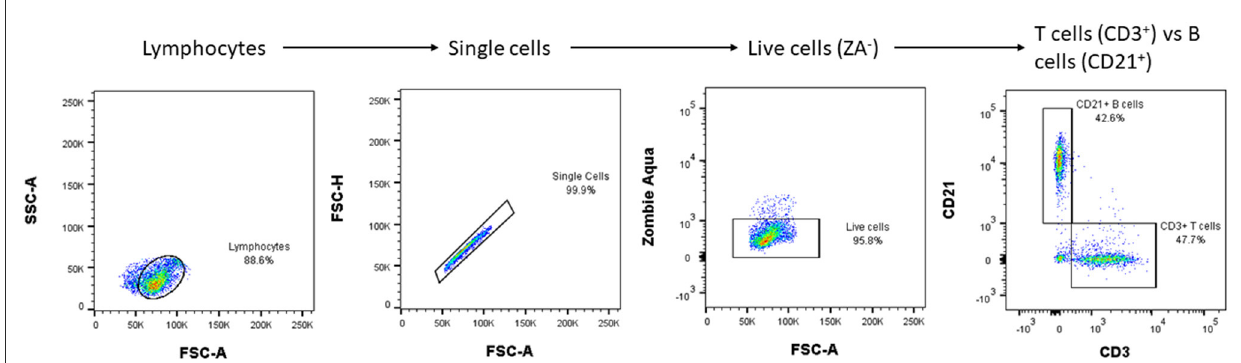
FIGURE1 An example of CSF flow cytometry results in a dog with MUO: a population of live lymphocytes is sorted, and two antibodies used to differentiate their subtypes. The procedure requires the CSF to be centrifuged and the resultant cells to be washed and then suspended in phosphate buffer saline with fetal calf serum before being incubated with primary antibodies (e.g., CD3, CD21) that are fluorescently labeled. Subsequent flow cytometry classifies the cells according to their fluorescence, size and shape. With further validation, CSF flow cytometry may help to define the relative importance of B- vs. T- lymphocyte-mediated inflammation and so guide the choice of immunosuppressive medication [e.g., cyclosporine mainly has suppressive effect on T-lymphocytes (113)] and, in future, guide development of appropriate monoclonal antibodies against specific types of lymphocytes. SSC, side scatter; FSC, forward scatter.